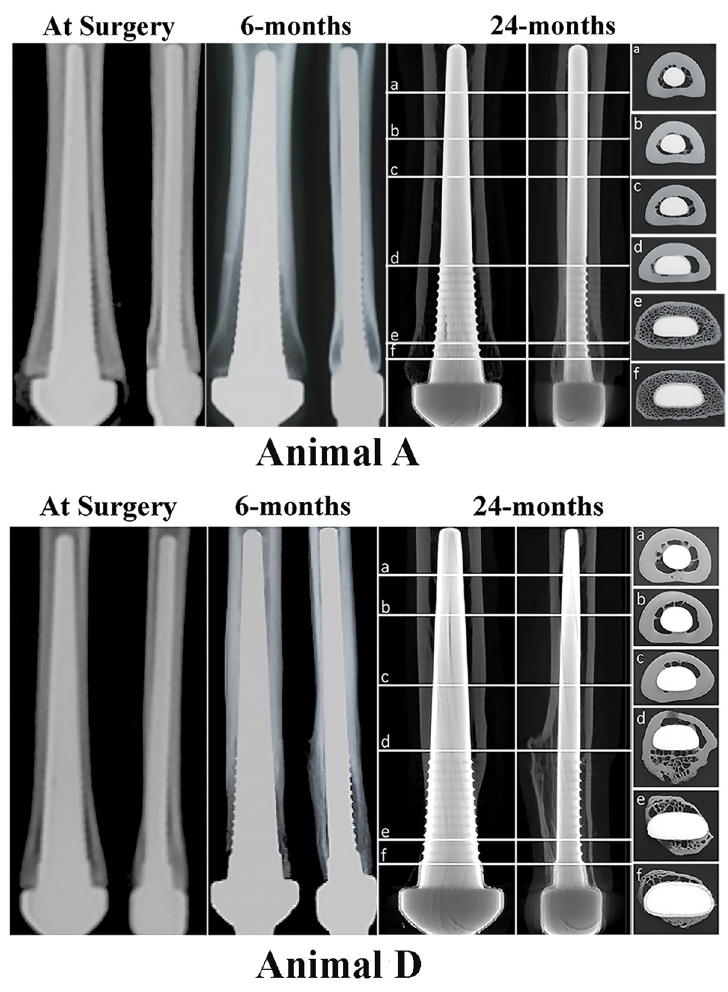
Fig 4. Serial radiographs taken at post-surgery (“Time 0”), at 6-month follow-up and at necropsy, 24-months post-implantation for Animal A and Animal D. Each panel shows AP view and ML view for each animal. Cross- sectional images in the far-right panel were acquired from μ -CT taken at 24-months post-surgery. Sections (a) from the proximal region through section (f) at the most distal region. Radiographs from Animal “A” show an endoprosthesis with an ideal end bearing fitting; Radiographs from Animal “D” show an endoprosthesis that was tightly bound in the proximal medullary canal. This resulted in distal bone resorption.